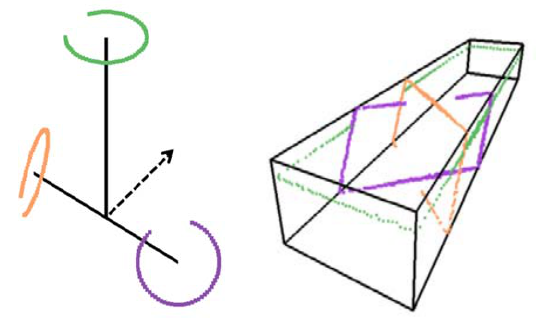
Figure 1. Configuration of the three 2D scanners with a 270° opening angle and resulting scan pattern in a